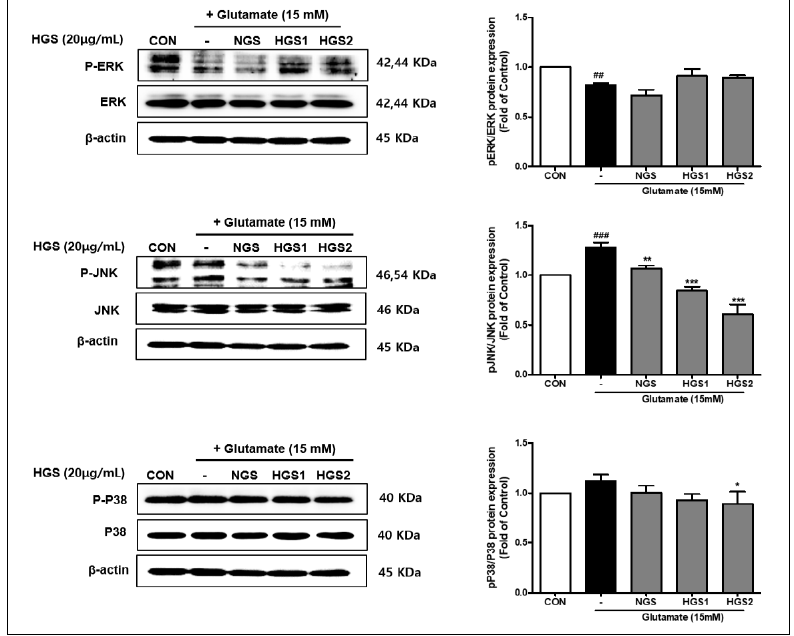
Figure 6. Effect of HGS on MAPK expression in glutamate-induced PC12 cells. Cells were treated with HGS (20 μg/mL) or the control (0.2% DMSO) for 1 h followed by glutamate (15 mM) for 24 h. Proteins were analyzed by Western blotting using β-actin as the loading control. Data are means ± standard errors of the mean (SEM). Significance was determined by a one-way ANOVA with Tukey’s post hoc multiple comparison test. ## p < 0.01 and ### p < 0.001,significance compared with the control (white bar). * p < 0.1, ** p < 0.01, and *** p < 0.001, significance compared with the gluta-